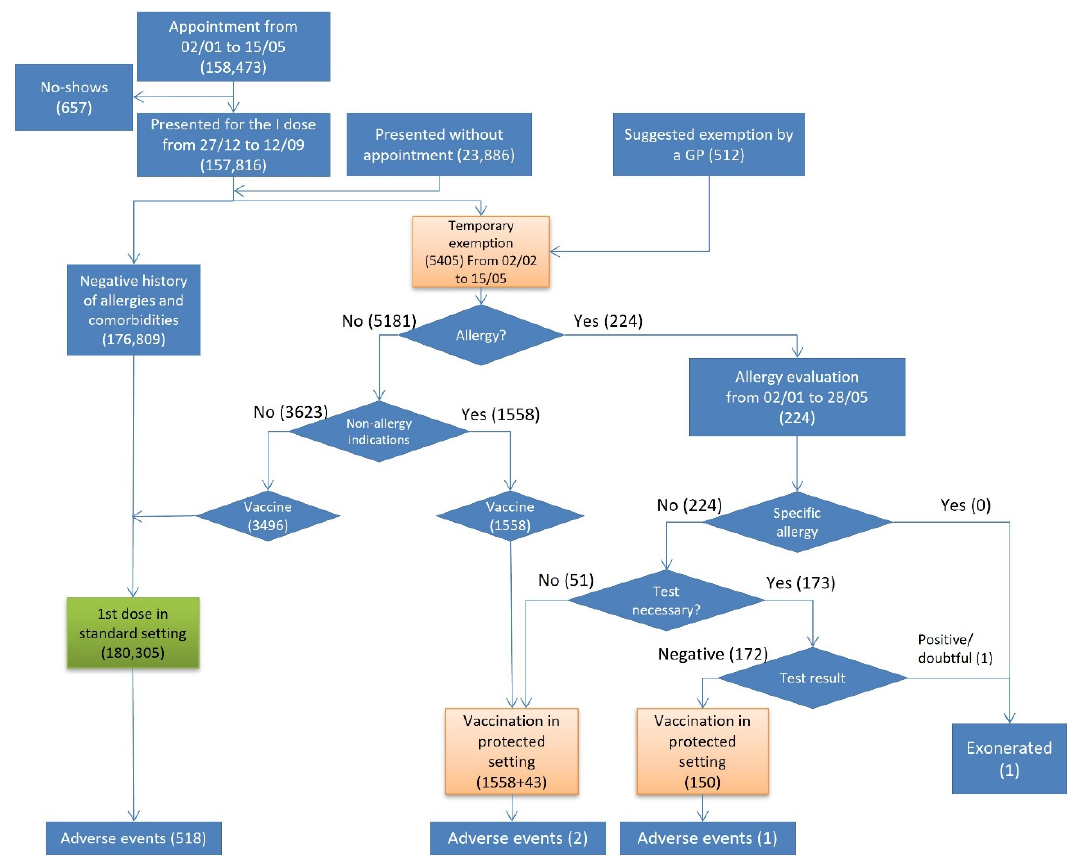
Figure 1. Flowchart of the first dose vaccinations, exonerations, and adverse events by risk path-